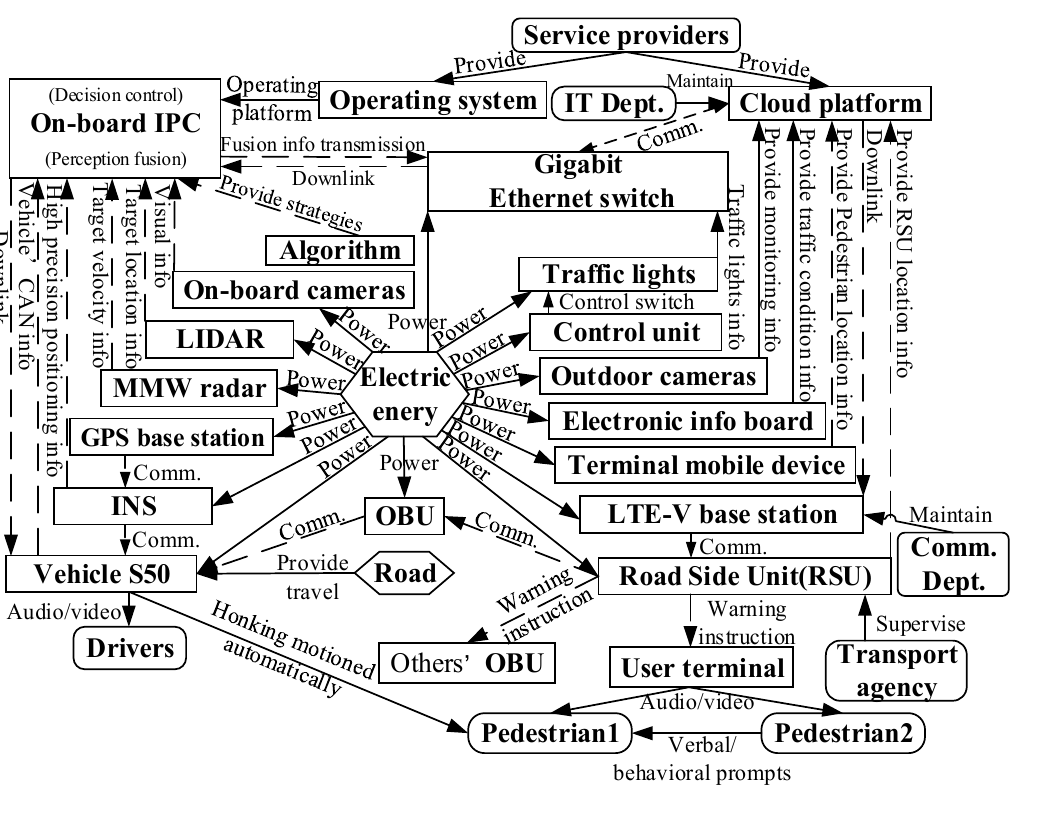
Figure 17. The function model of the extended CWS.